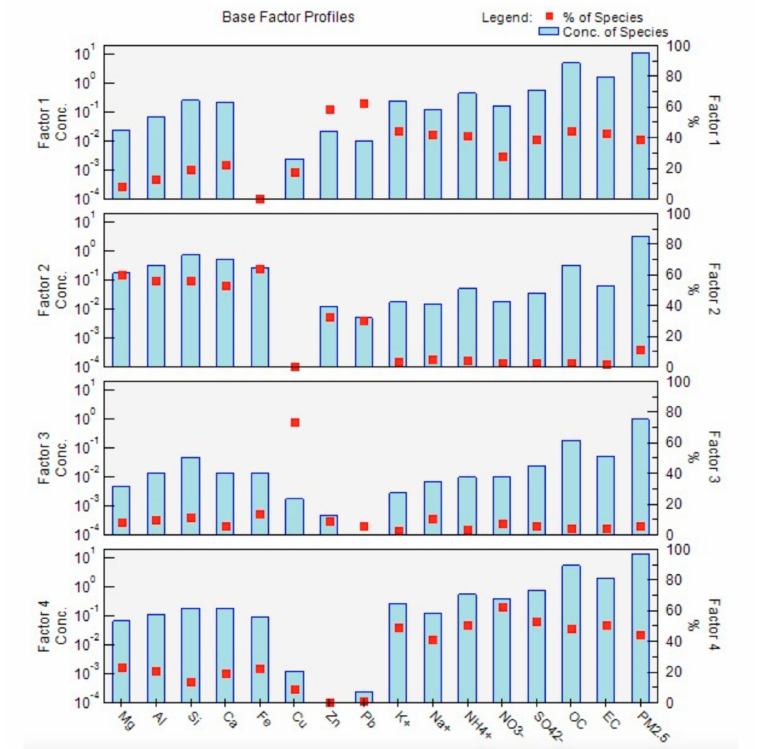
Figure 7. Factor profiles: division of elements into individual factors, and their characterization from measurements of PM 2.5 taken in the dry season in